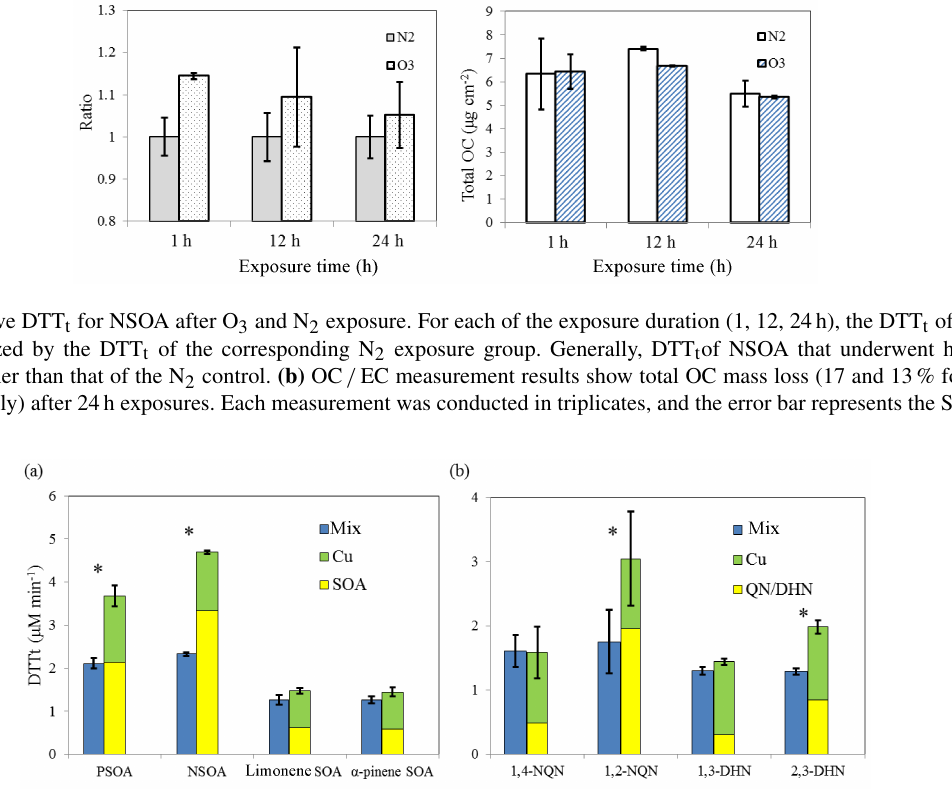
Figure 8. Significant OP depletions were observed when PSOA (43 ± 4%), NSOA (50 ± 6%), 1,2-NQN (42 ± 7%), and 2,3-DHN (35 ± 1%) mixed with Cu (II). The asterisk indicates significant difference between a pair of bars at a 95% confidence